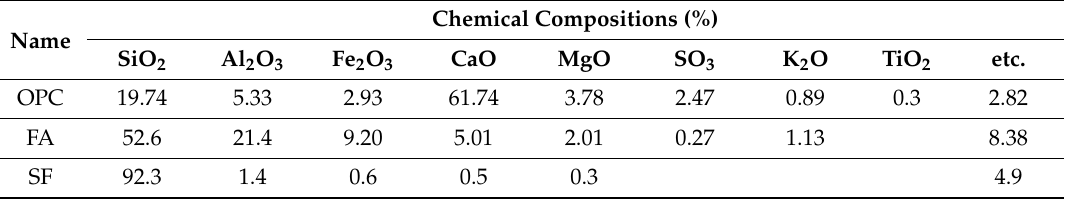
Table 2. Chemical composition of binder. Silica fume, (SF).